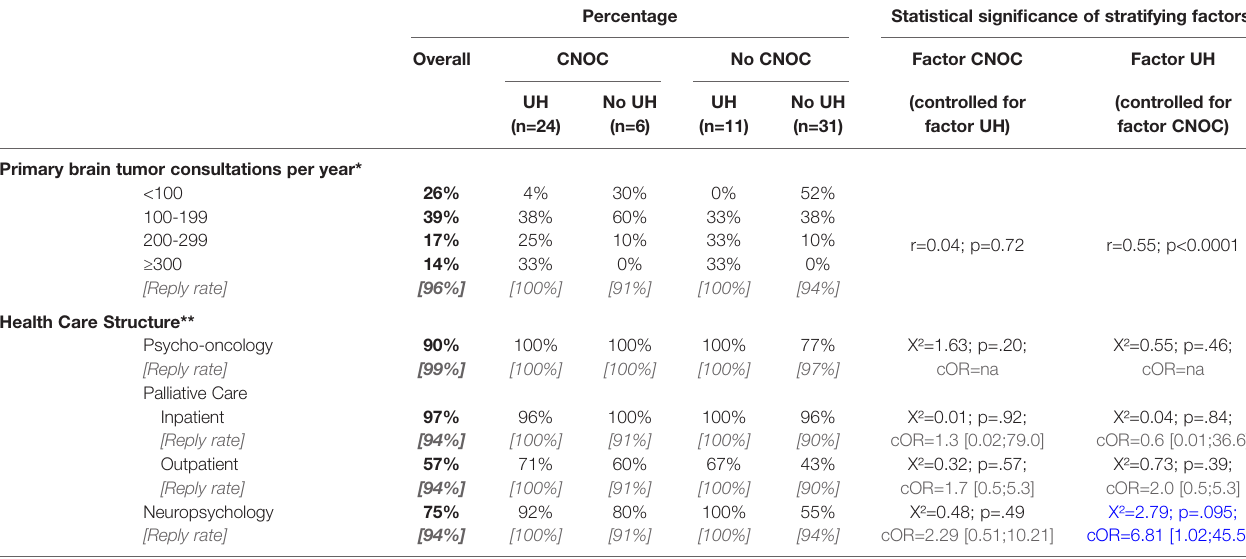
TABLE 2 | Caseload and health care